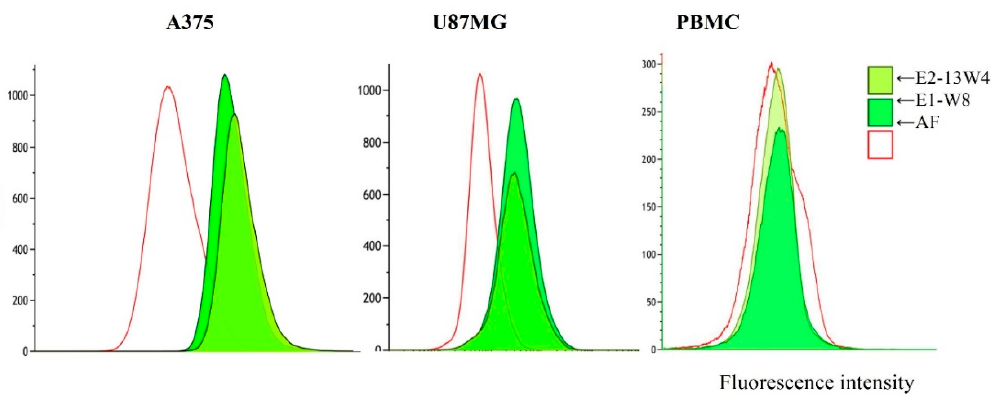
Figure 11. Histograms showing fluorescence intensity at 530 nm of A375 cells, U87MG cells and human PBMC before (autofluorescence [AF], red line) and after 24-h incubation with the E2-13W4 or E1-W8 protein (green filled curves).